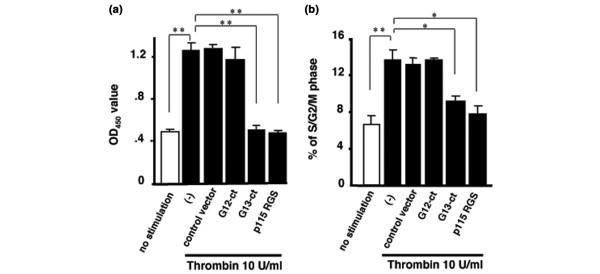
G13 and Rho signaling in thrombin-mediated synovial proliferation and S-phase progression in RA SFs. Rheumatoid arthritis (RA) synovial fibroblasts (SFs) infected or not infected with adenoviruses encoding GFP (control vector), the C-terminal regions of Gα12 (Gα12-ct), Gα13-ct, or p115RGS were cultured for 48 hours in DMEM containing 1% FCS and then stimulated with 10 units/ml thrombin. At 24 hours after the thrombin stimulation, proliferation assay and cell-cycle analysis of RA SFs were performed. (a) Effect of Rho signaling inhibition on thrombin-induced cell proliferation. Numbers represent the optical density (OD) as measured by ELISA plate reader at 450 nm. (b) Effect of Rho signaling inhibition on thrombin-induced cell-cycle progression. Numbers represent the percentage of cells that exhibited mean channel fluorescence (FL2-H) in the S/G2/M phase. Data are expressed as mean ± standard deviation of five experiments, using five independent donors. (-), cells without infection; p115RGS, regulator of G-protein signaling domain of p115Rho guanine nucleotide exchange factor. *P < 0.05, **P < 0.01, in comparison with thrombin stimulation.